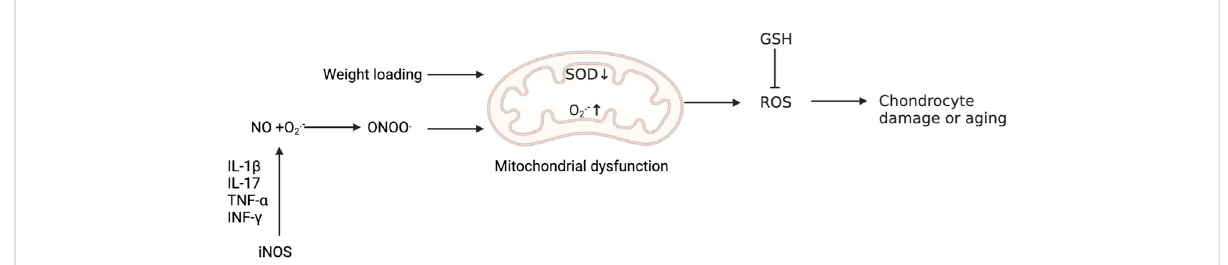
FIGURE 3 Oxidative stress is involved in the injury and senescence of chondrocytes. Weight loading promotes the production of O 2 − in mitochondria and reduces the expression of SOD, while mitochondrial dysfunction induced by ROS in mitochondria will further lead to cartilage degeneration. The production of NO by activating iNOS is initiated by signals from proin fl ammatory cytokines, including IL-1 β , IL-17, tumour necrosis factor- α (TNF- α ) and interferon- γ (INF- γ ).O 2 − reacts with NO to produce ONOO − . Peroxynitrite caninducemitochondrialdysfunction, resultingin chondrocyte damage. Reduced glutathione (GSH) can reduce the level of